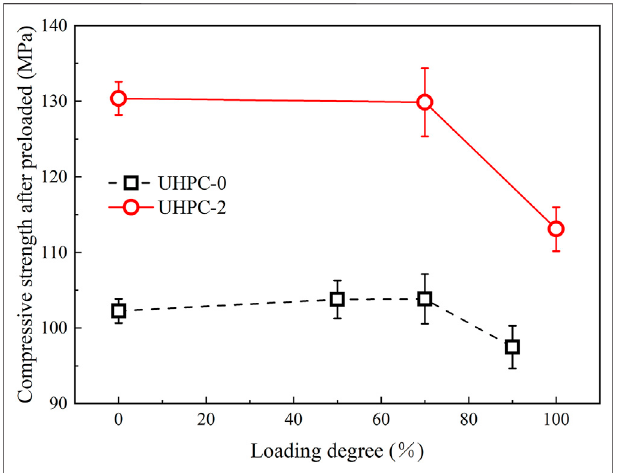
FIGURE 4 | Change in strength of unhealed specimens under different preload